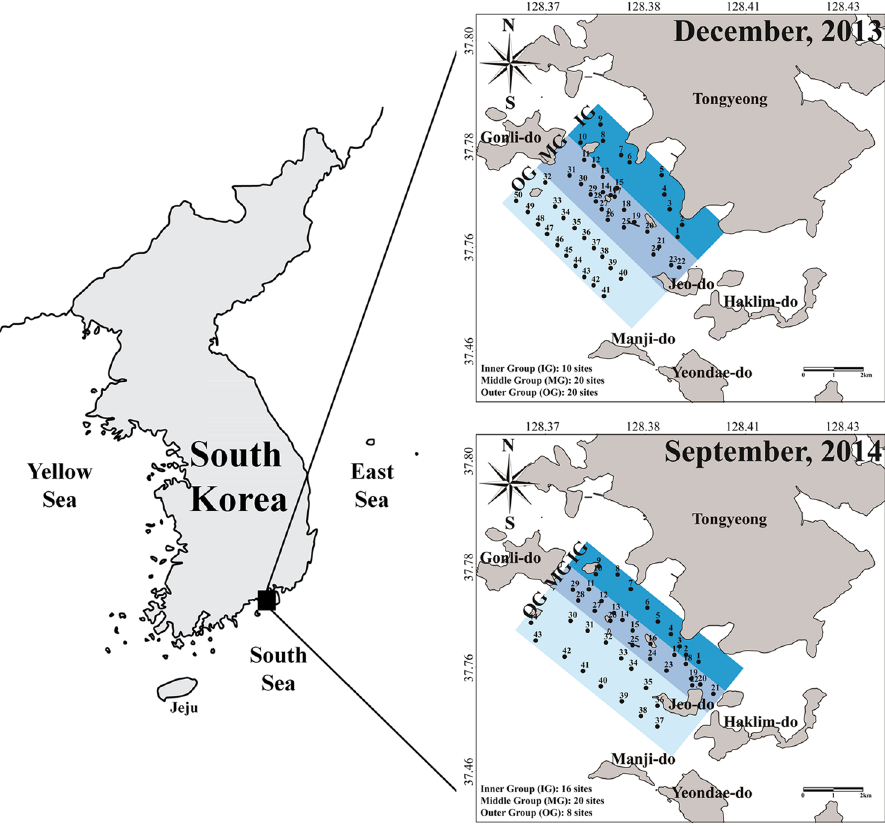
Figure 6. Map showing the sampling sites of surface sediments in Tongyeong coast (South Sea) of South Korea during December 2013 and September 2014. IG, inner group; MG, middle group; OG, outer group. All maps were generated with Surfer v12.2.705